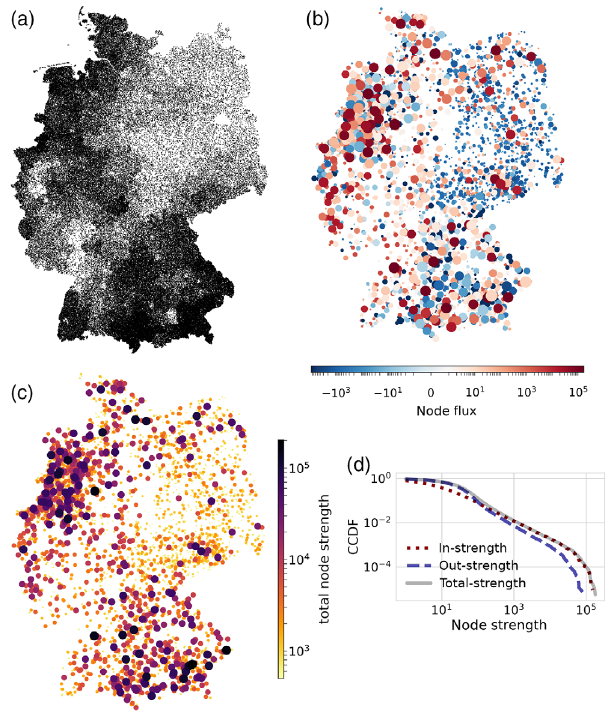
FIG. 11. Node strength and flux analysis of cattle trade in the year 2010. (a) Geographic location of all 183 454 premises that have been recorded. (b) Color indicates net animal flux, i.e., the difference between in- and out-directed animal flux. Node size corresponds to the sum of both [see diagram (c)]. (c) Color and size indicate the total node strength, i.e., the sum of incoming and outgoing animals. (d) CCDF of the in, out, and total